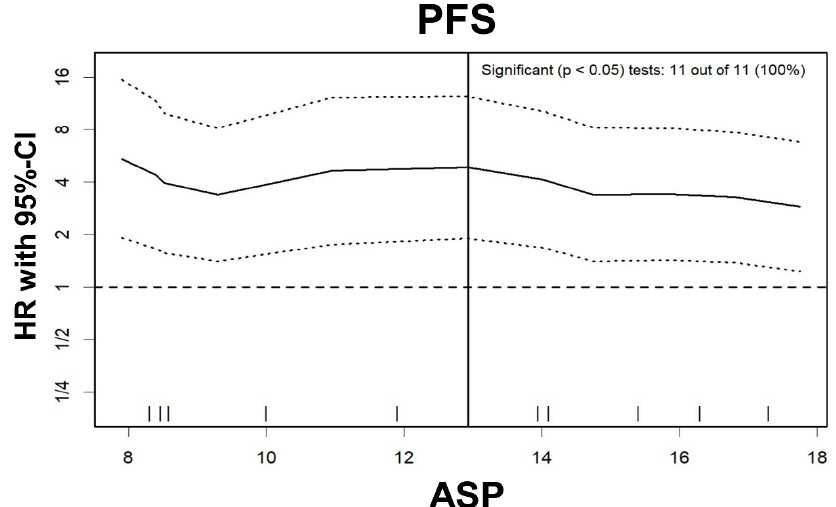
Figure 3. Hazard ratio plot for asphericity (ASP). The hazard ratio (HR; solid line) and its 95%- confidence interval (dashed lines) are illustrated for ASP cut-offs between 8–18%. A dashed horizontal line represents equal PFS in patients with high or low ASP, respectively (i.e., HR of 1.0). The vertical solid line displays the optimal ASP cut-off (12.9%). Furthermore, the frequency of possible ASP cut- off values between 8–18% with significant results in the log-rank test is given (11 out of 11 possible cut-offs).